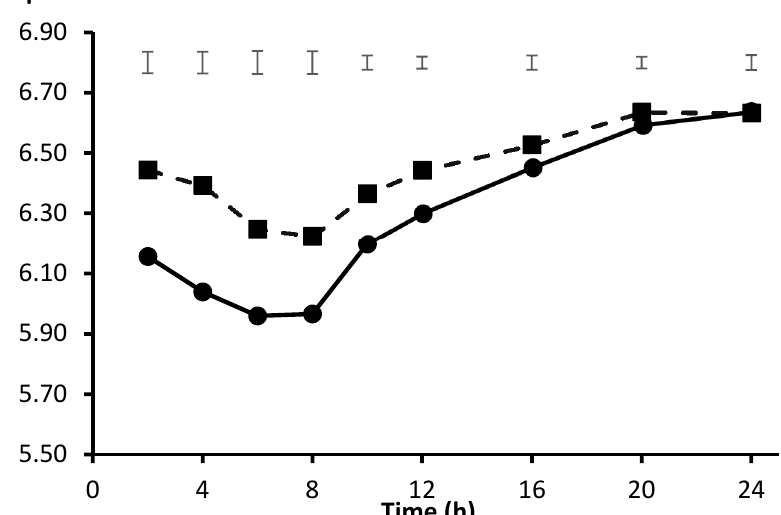
Figure 3. Average pattern of incubation pH from substrates incubated with inocula from a concentrate diet (CI, • ; initial pH 6.45 ± 0.15) or a forage diet (FI, (cid:4) ; initial pH 6.87 ± 0.02). Upper bars show standard error of means ( n = 3). Adapted from Amanzougarene et al. [24].